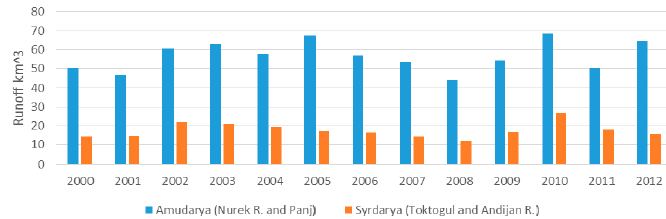
Figure 4. Volume of runoff formation (km 3 ) within hydrological years in the (unregulated) upstream catchments of Amu Darya and Syr Darya, data source: CAREWIB-portal [63].